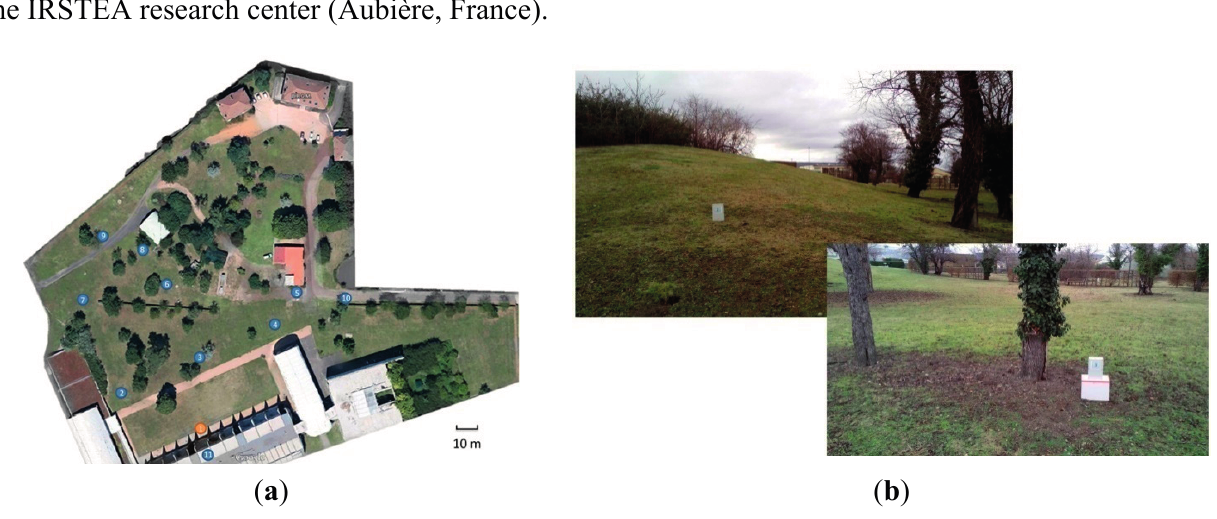
Figure 5. ( a ) A plan of testbed deployment; ( b ) Testbed setup: photos of No. 2 and No. 3 deployed IWoTCore